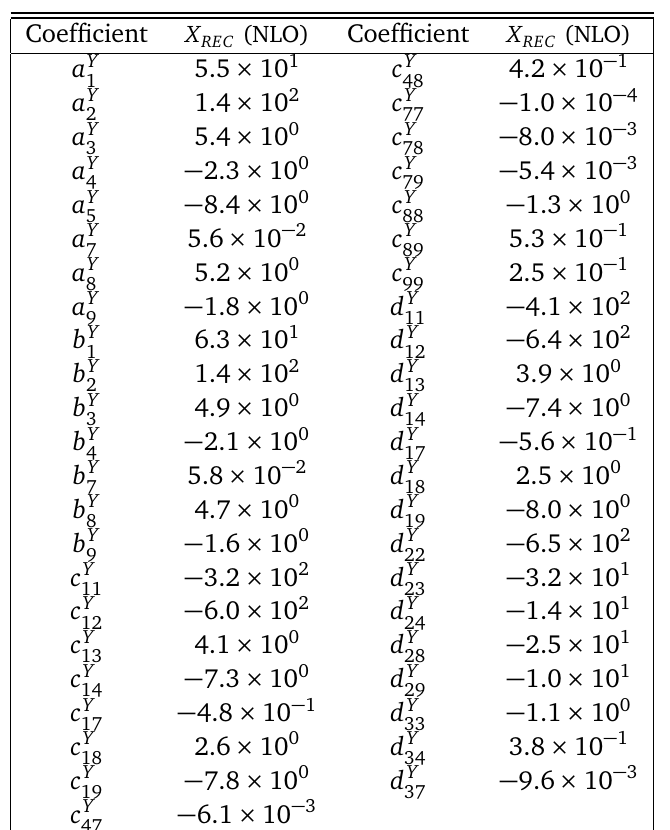
Table 5: Coefficients for the LM with the physically-motivated basis expressed in Eq. (38) with the constraints given in Eq. (39) and Eq. (40) for the x momentum frac- tion.